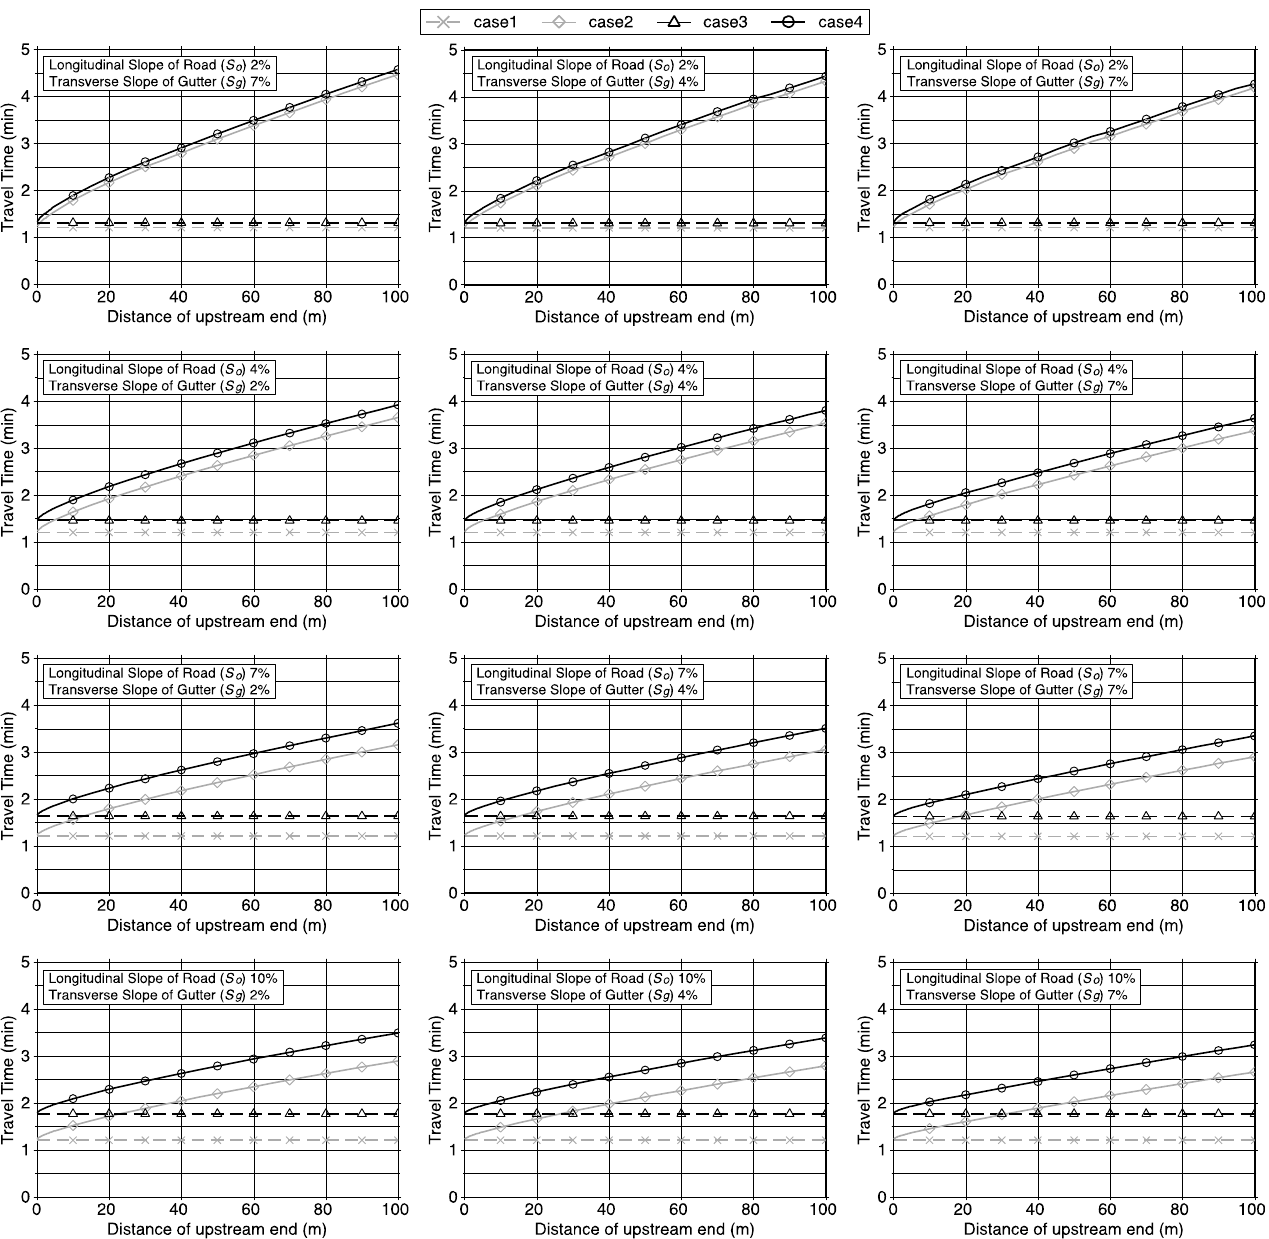
Figure 5. Travel times in terms of the longitudinal road slop and the transverse gutter one.